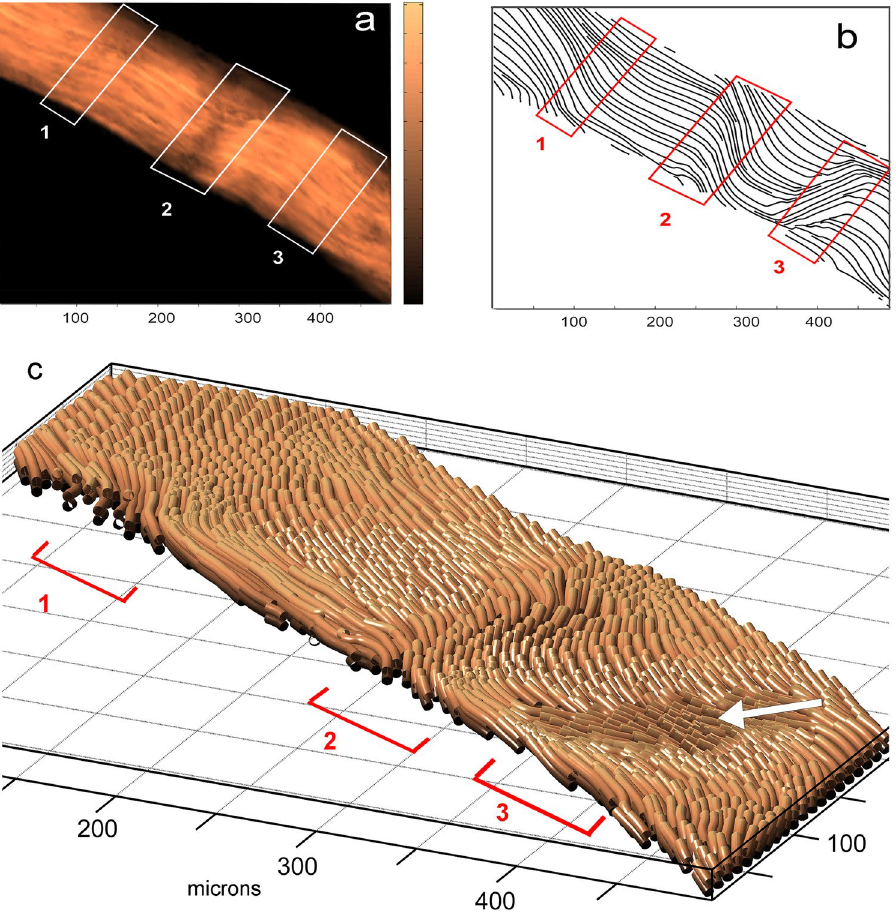
Figure 5. Comparison of 2-D SHG images with SHARP images in a longitudinal section of RTT: ( a ) 2-D SHG intensity scan; the white boxes correspond to regions of collagen crimp identified from orientation data; ( b ) 2-D in-plane orientation angles ( φ ), displayed as streamlines; the red boxes correspond to regions of collagen crimp; ( c ) SHARP image of the same RTT sample; the red brackets indicate the same regions as the boxes in the 2-D images; the white arrow indicates the fibrillar bundle seen in box 3 in panel